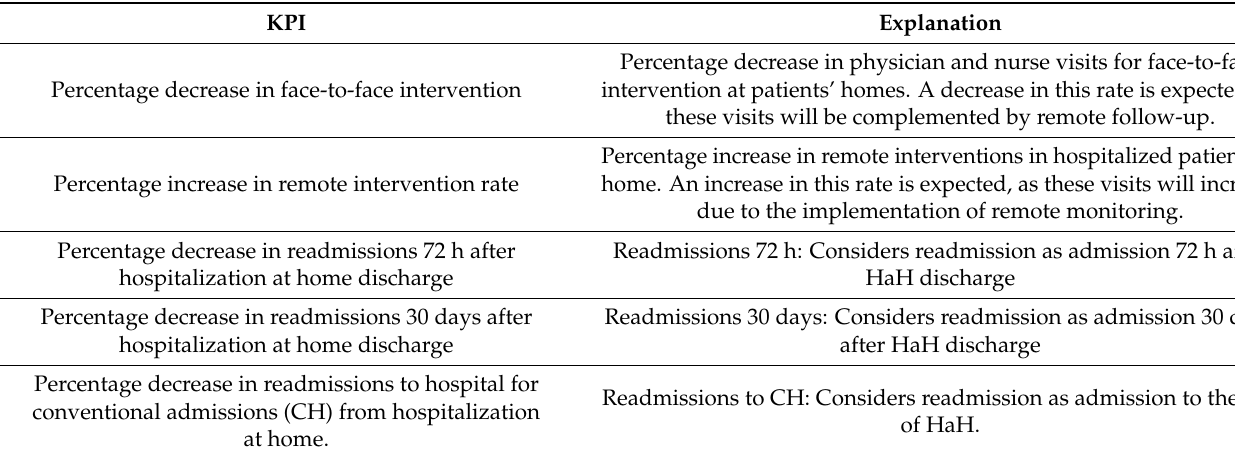
Table 2. Definition of